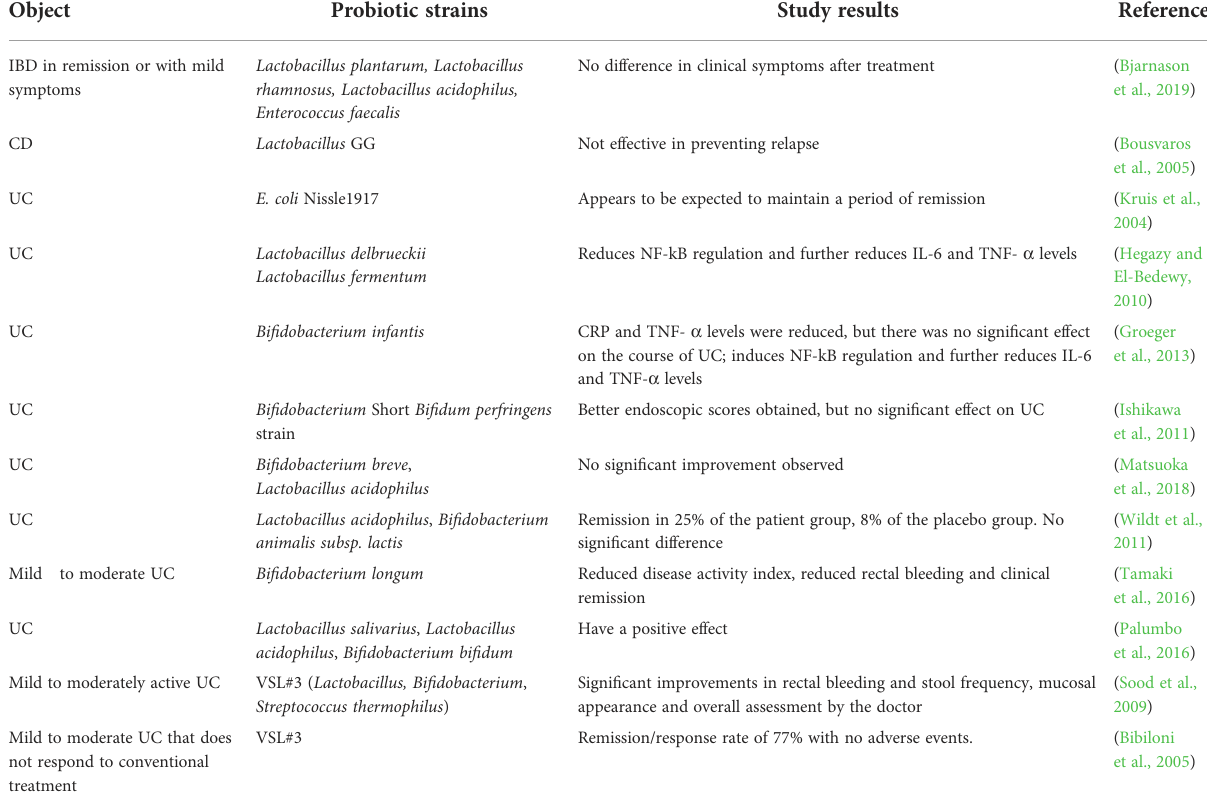
TABLE 2 Summary of population-based clinical trials on probiotics for IBD.